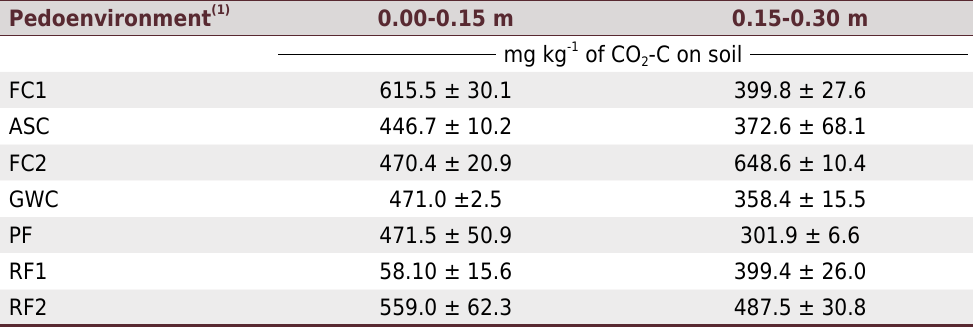
Table 3. Accumulated values of microbial respiration of soils under different pedoenvironments and at two soil depths in the Viruá National Park, Roraima, Brazil